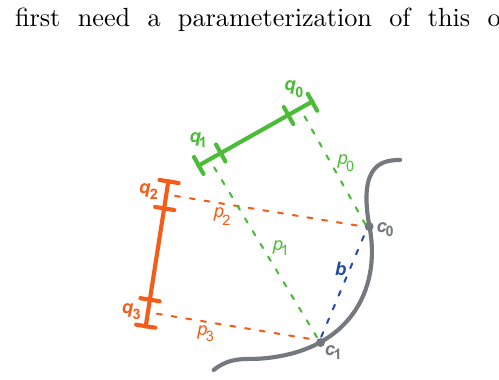
Fig. 3 Light scattering b between two surface points c i , illuminated by two projectors in a concave surface